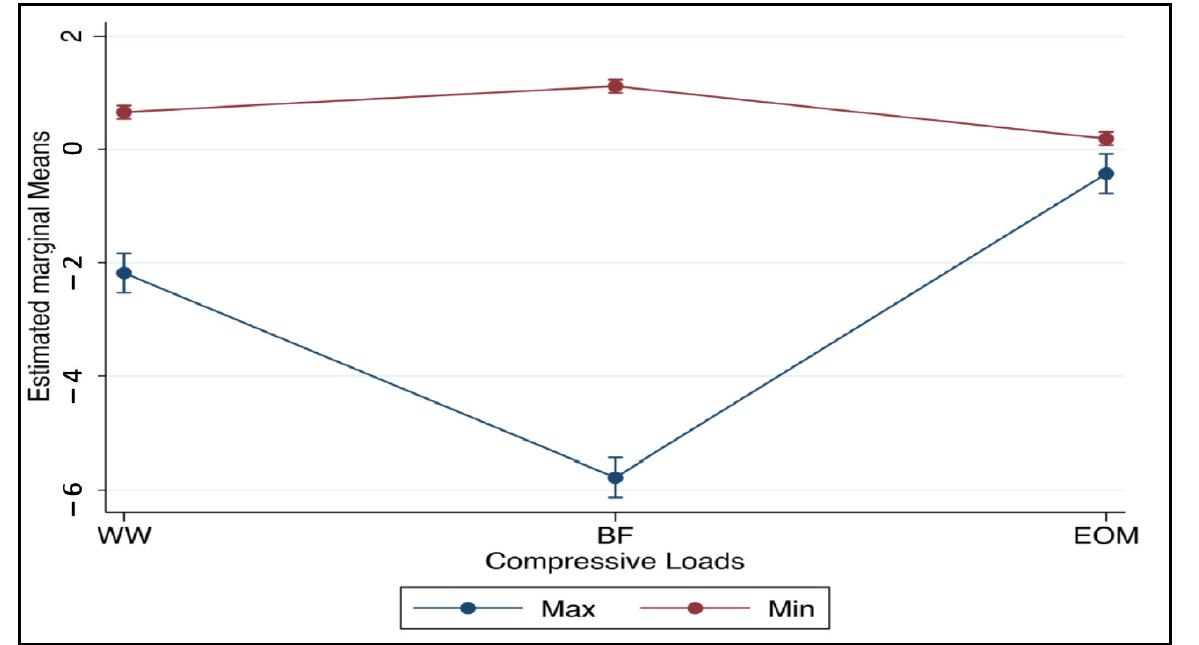
Figure 11. Estimated prediction means of the balanced forces (BF) technique, watch winding (WW) motion, and the envelope of motion (EOM) by the highest and lowest compressive loads with 95% confidence intervals.